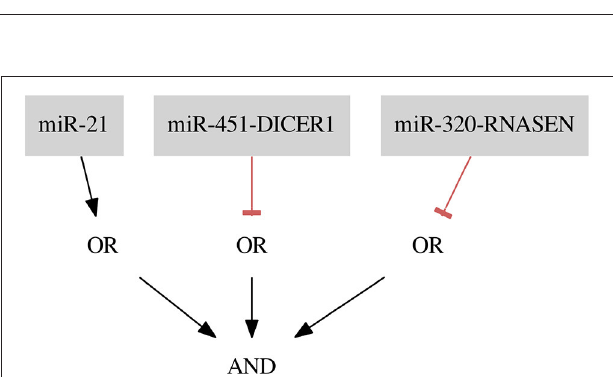
FIGURE 6 | Classifiers for the breast cancer Triple- data set.